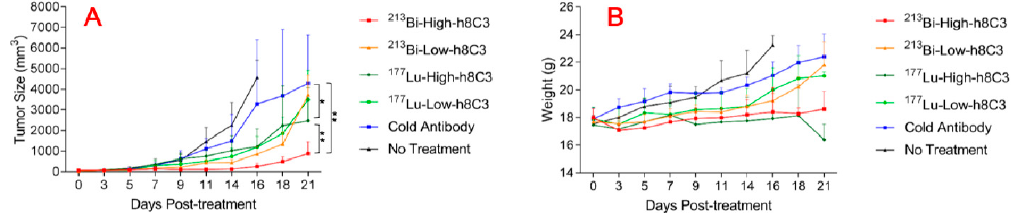
Figure 3. Tumor volumes and body weights of B16-F10 melanoma-bearing mice treated with 177 Lu-h8C3 and 213 Bi-h8C3. ( A ) Tumor volume and ( B ) body weight. Low dose—7.4 MBq; high dose—14.8 MBq. * indicate statistical significance.